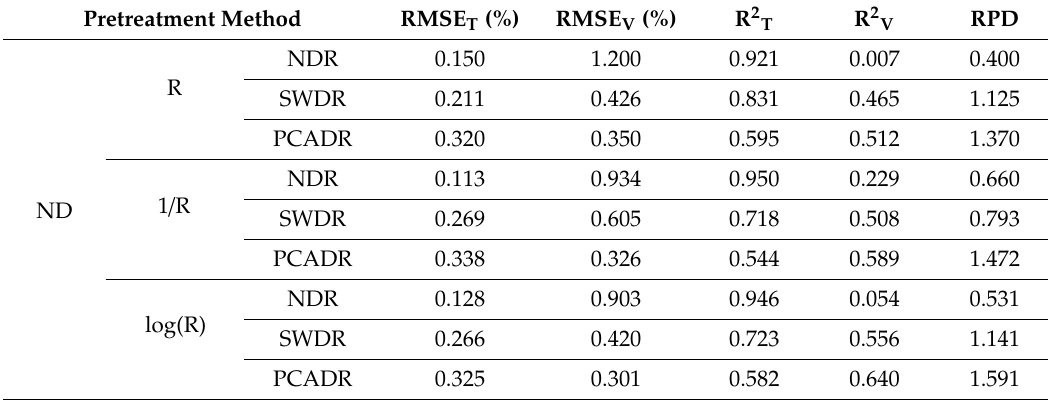
Table 4. SOM Content Estimation Model Results Based on the PLSR Model in 54 Different Spectral Pretreatment Methods.